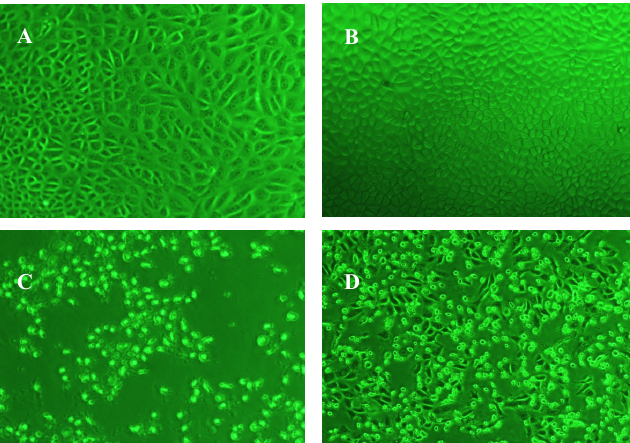
Figure 3. Comparative characteristic cytopathic effect (CPE) of wild types (day 3) and clonal populations (day 7). Images were taken at 40× magnification. ( A ) hRz #9 and ( B ) hRz #14 expressing cells with no CPE where ( C ) and ( D ) are untransformed Vero cells showing severe CPE. 3.3. TCID 50 -­‐‑IFA Analysis of CHIKV Suppression in Clones Lacking Visible CPE